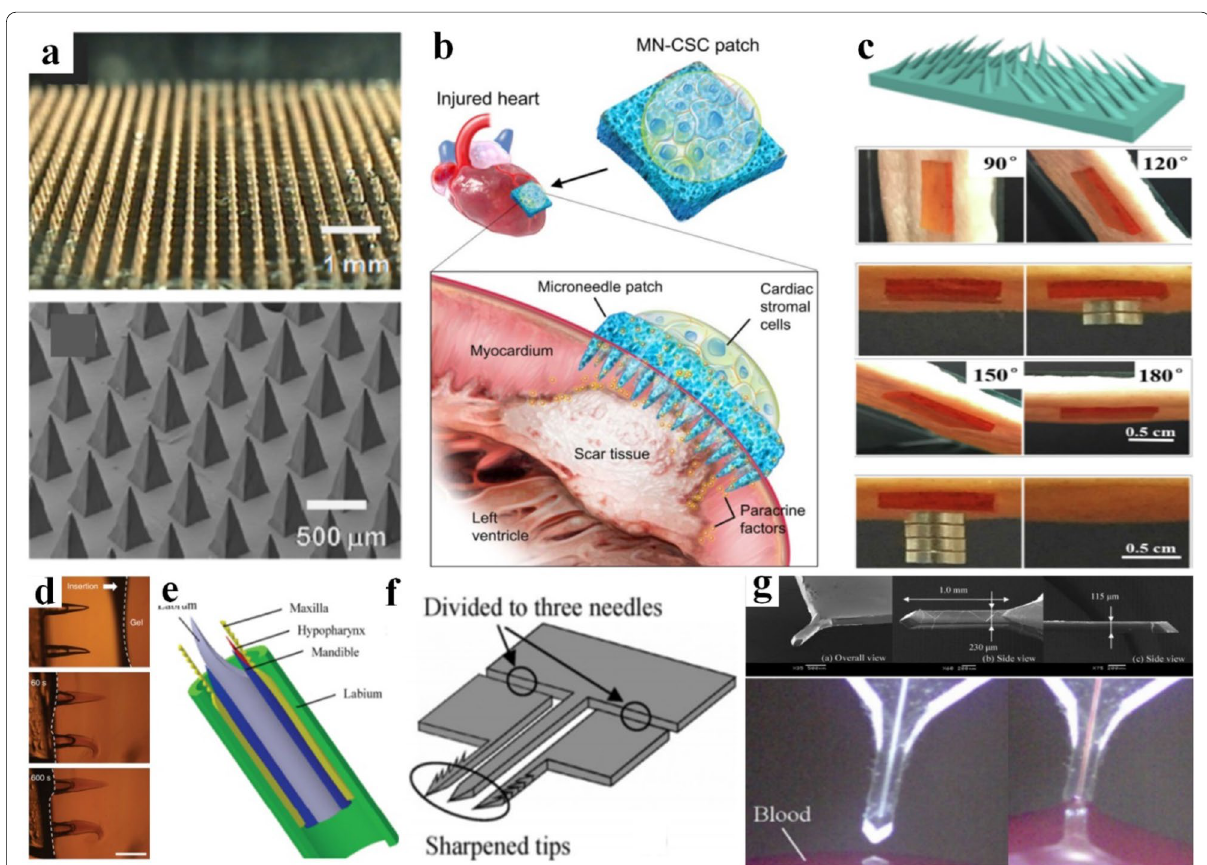
Figure 9 Microneedles for drug injection: ( a ) microneedle array for drug delivery, ( b ) cardiac cell-integrated microneedle patch, ( c ) bioinspired clamping microneedle array, ( d ) bioinspired swellable microneedle for tissue interlocking, ( e ) mosquito-proboscis-inspired needle, ( f ) mosquito-proboscis-inspired needle, and ( g ) microneedle for blood